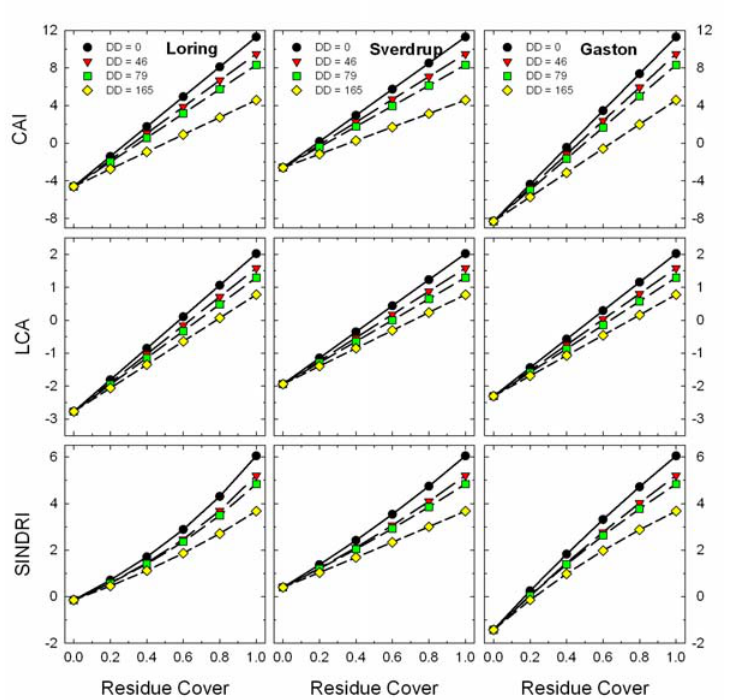
Figure 9. Expected responses of advanced residue indices (Equations 7–9) to changes in residue cover for scenes with mixtures of four ages ( i.e. , decomposition days, DD) of wheat residues and three